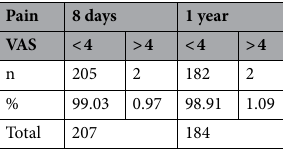
Table 5. Pain control.